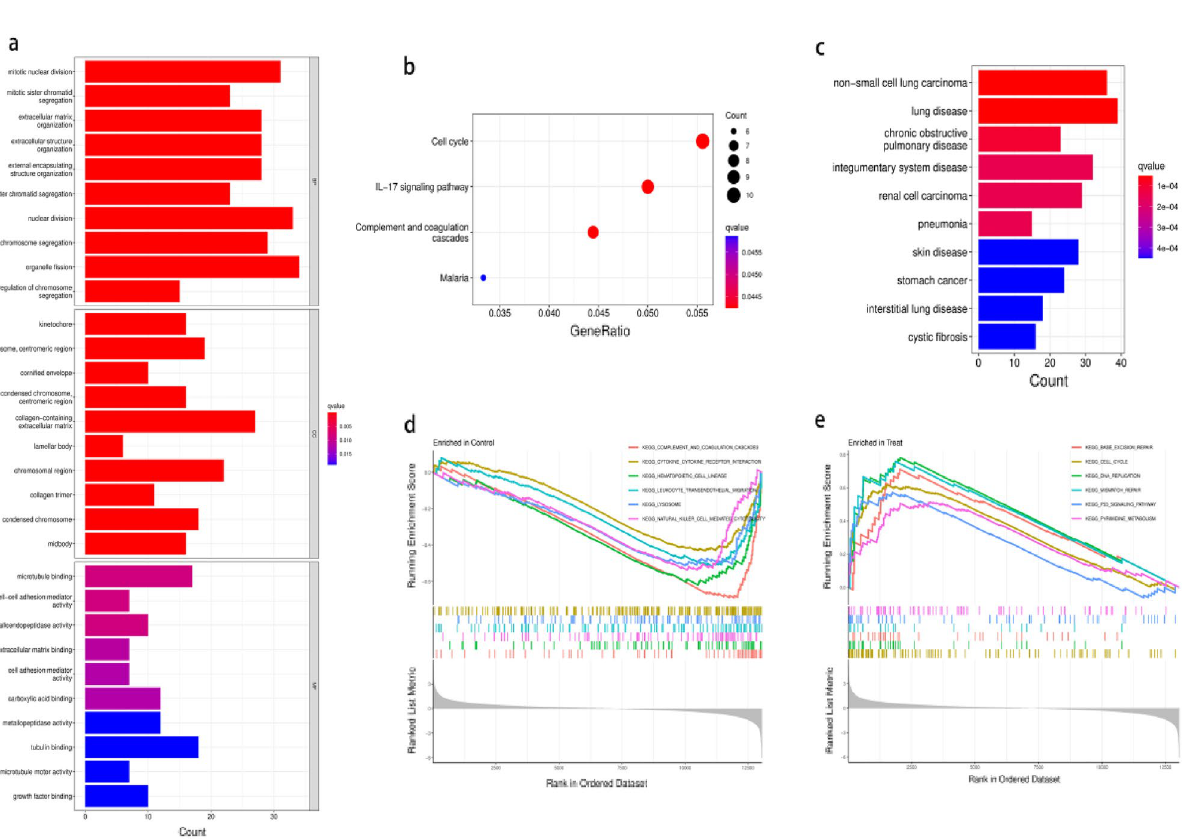
Figure 3. Functional enrichment analysis of DEGs. The P value represents the colour depth of the node. The size of the node implies the number of DEGs. ( a ) GO functional enrichment analysis results for DEGs, including Biological process(BP), molecular function(MF) and cellular component(CC). ( b ) KEEG enrichment analysis reveals signalling pathways highly relevant to NSCLC. ( c ) DO functional enrichment analysis results of DEGs. ( d ) GSEA shows the top six signalling pathways most associated with normal lung tissue. ( e ) GSEA shows the top six signalling pathways most associated with